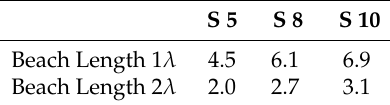
Table A2. Reflection coefficients for different lengths and damping coefficients S of the NB